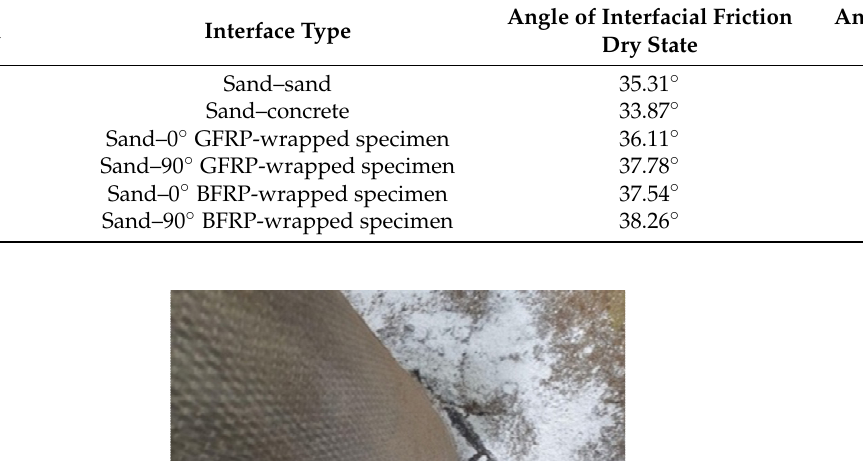
Table 8. Angle of the interfacial friction.